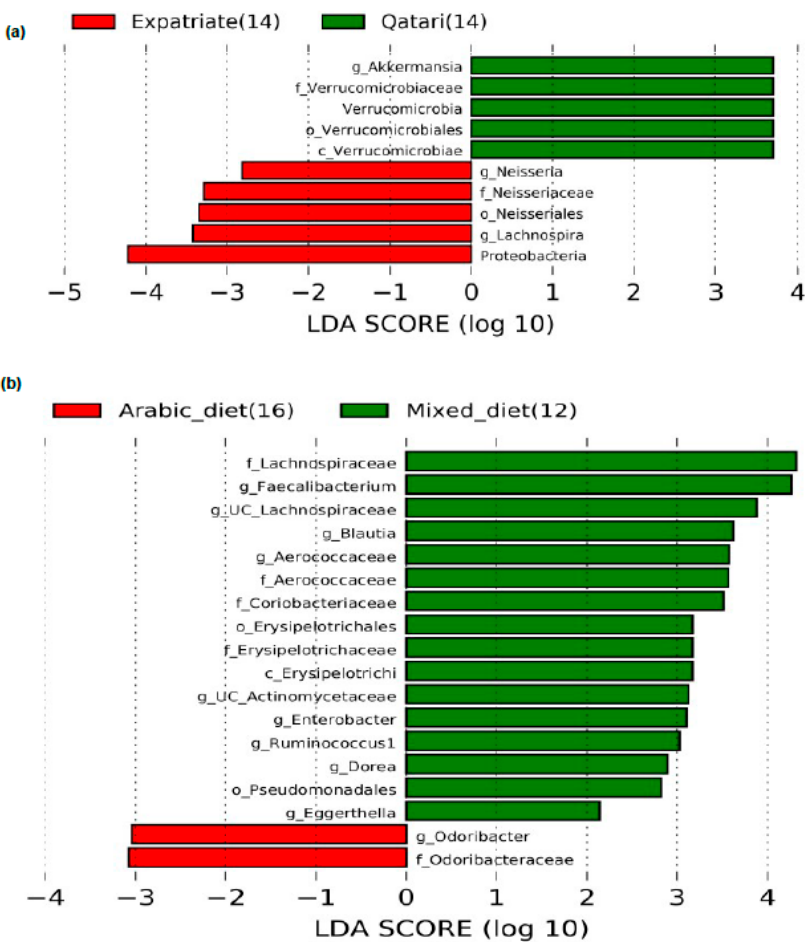
Figure 5. Impact of diet and nationality on genus Akkermansia in T1DM subjects. LEfSe analysis has revealed that ( a ) the Akkermansia was only enriched in the Qataris T1DM subjects, and ( b ) Akkermansia was not significantly different between the Arabic diet and mixed diet consumed subjects. LDA cutoff value > 2.0 g_UC represents genus_unclassified.